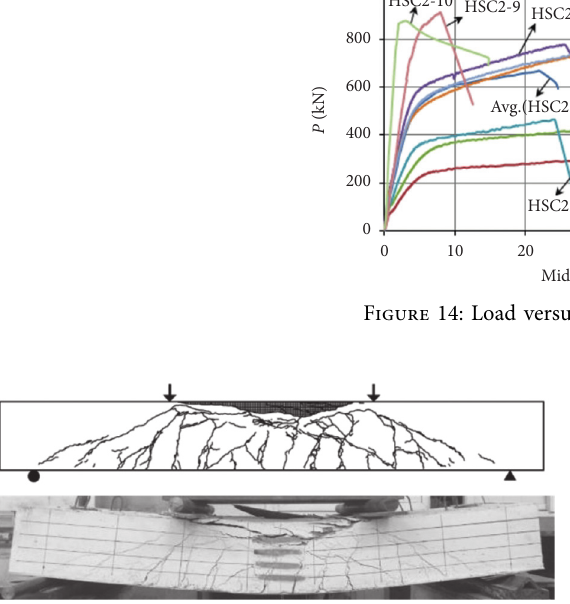
Figure 15: Deformation and crack distribution in HSC2-8.